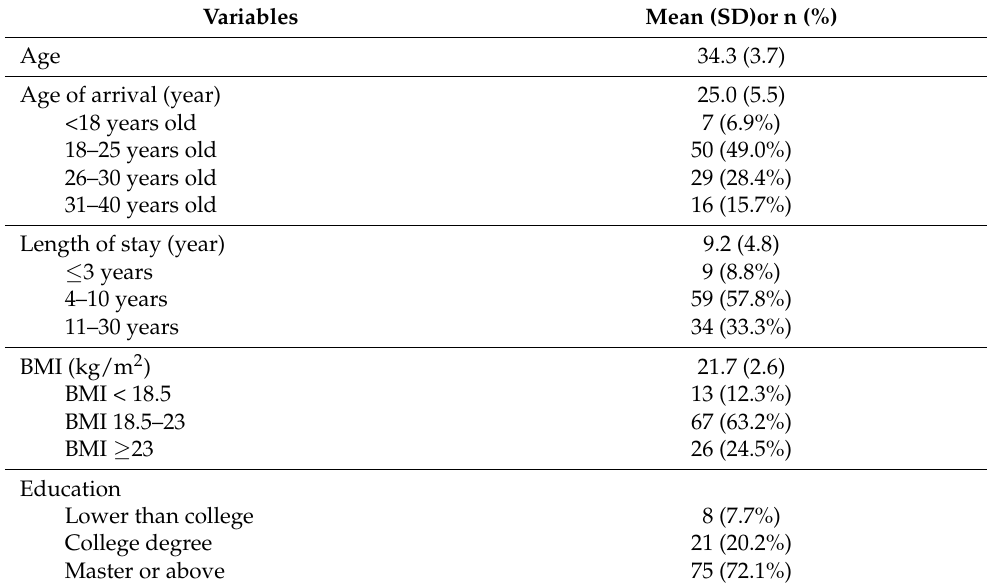
Table 1. Socio-demographic and clinical characteristics of Chinese immigrants in the US with prior GDM (n =